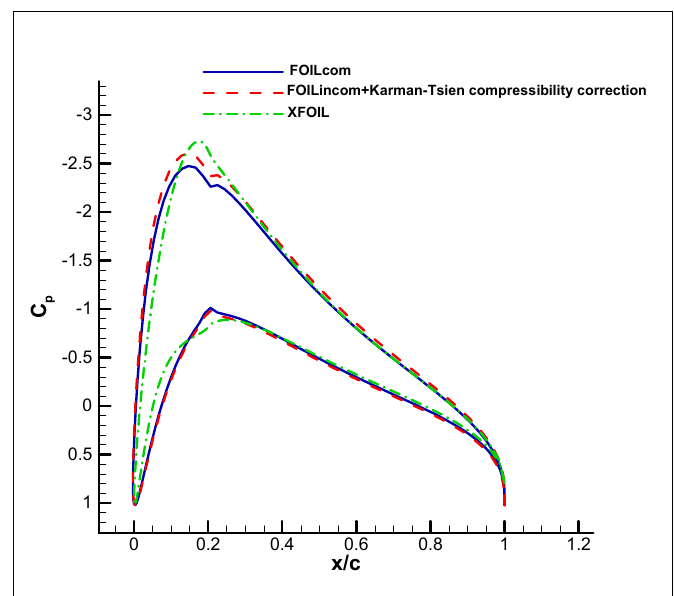
Figure 23. Comparison of surface pressure coefficient distributions for NACA 2240 airfoil ( M ∞ = 0.3, α = 3 ◦ ) using the codes FOILcom, FOILincom along with the Karman-Tsien compressibility correction, and XFOIL.